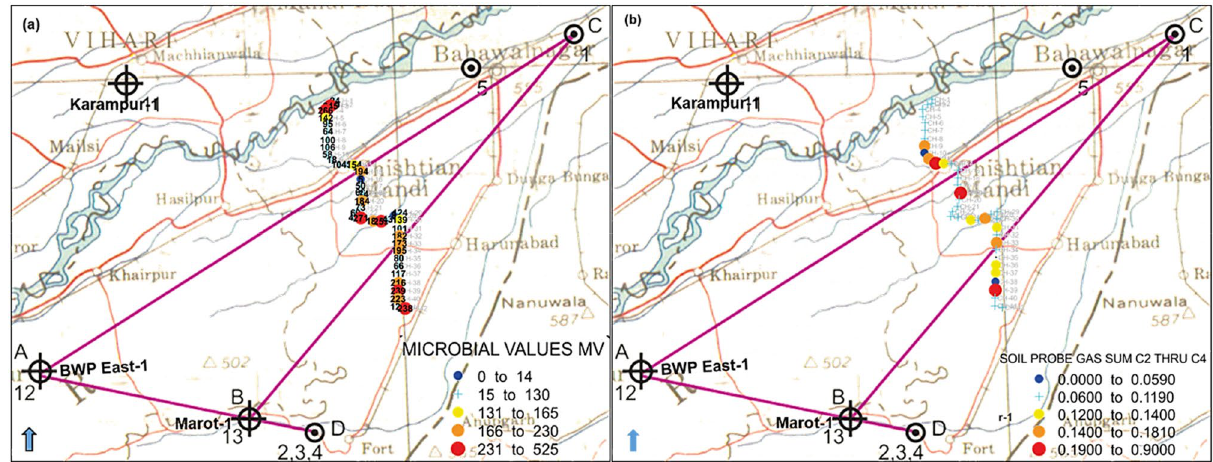
Figure 13. ( a ) Distribution plot of microbial value anomalies, and ( b ) distribution plot of soil probe C 2 –C 4 hydrocarbons. Microbial and soil probe hydrocarbon values overlap with toposheets of the study